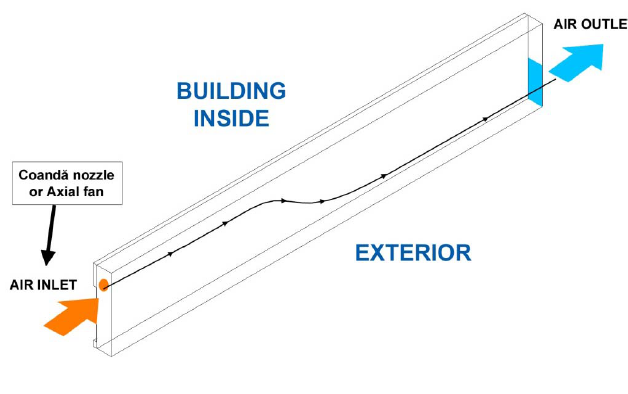
Figure 2. Example of the integration of mechanical ventilation systems in